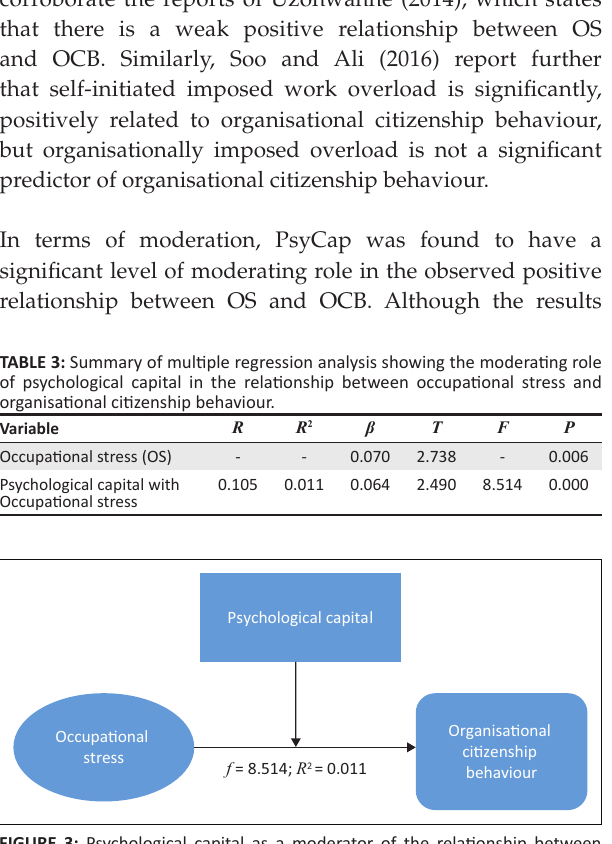
FIGURE 3: Psychological capital as a moderator of the relationship between occupational stress and organisational citizenship behaviour.